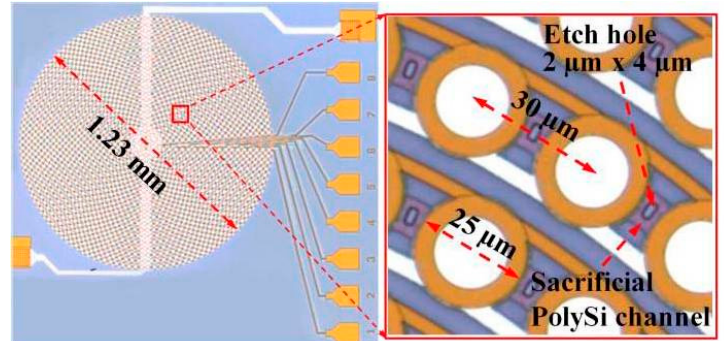
Figure 2. High fill-factor annular array for high frequency piezoelectric micromachined ultrasonic transducers (PMUTs), optical image of the PMUTs array ( Left ) and close-up picture of individual 25 µm diameter PMUTs ( right ). Left: The eight channels are connected to individual bond-pads through the top-electrode metal and a single bond-pad is connected to the common bottom electrode. Right: The sacrificial poly-Si is removed via 2 µm by 4 µm etch holes between each PMUT. The rings of PMUTs are connected through the top-electrode metal layer (dark gold) and bottom electrode (white) (R eproduced with permission from IEEE [35]).